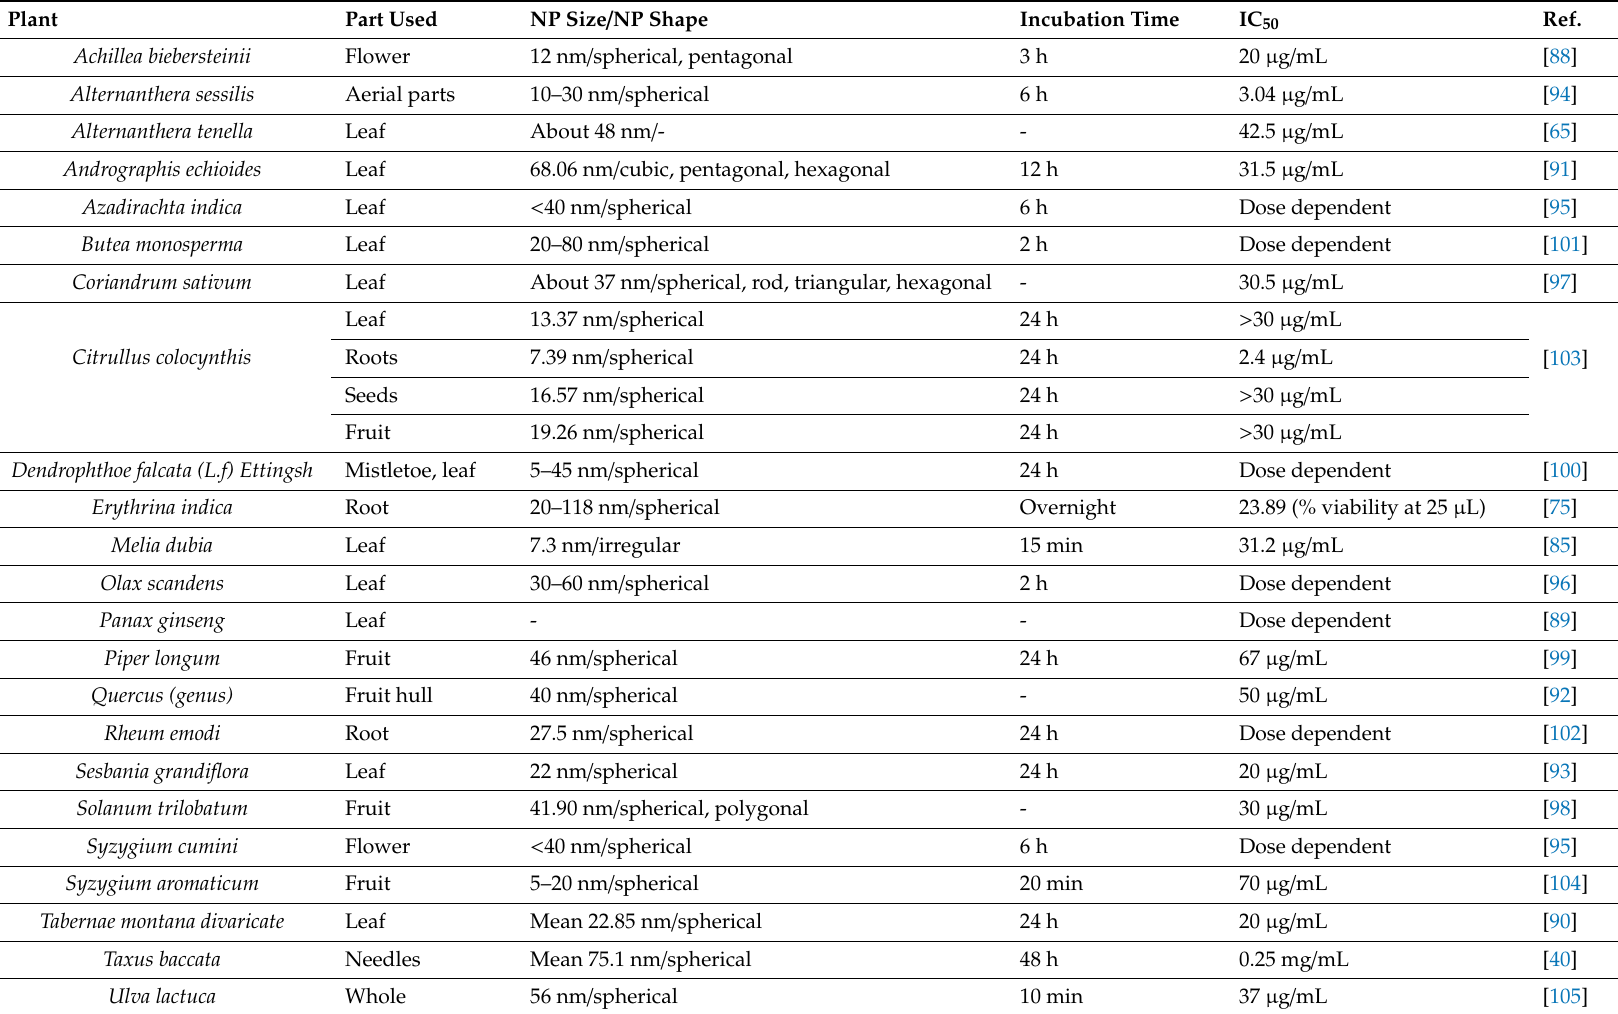
Table 2. Studies AgNPs from plants that inhibit the breast cancer cell line